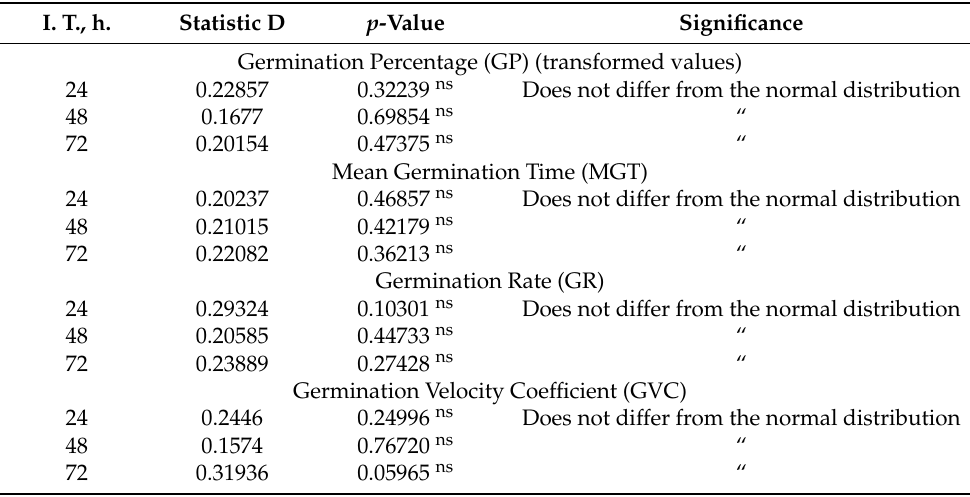
Table 1. Normality test for the variables germination percentage (GP) (transformed values), mean germination time (MGT), germination rate (GR) and germination velocity coefficient (GVC). I. T., h. Statistic D p